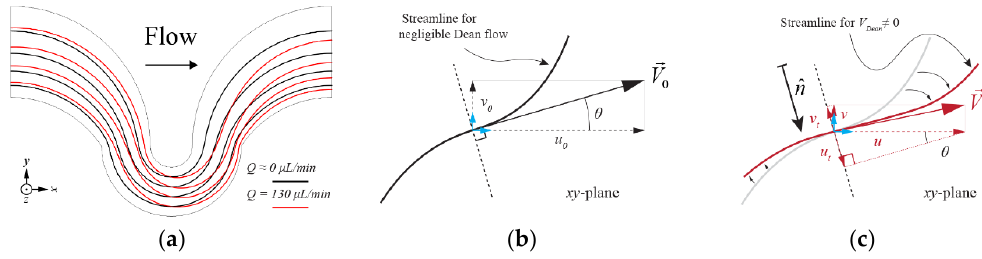
Figure 3. ( a ) Obtained streamlines for a flow with negligible Dean flow (black lines) and for Q = 130 μL/min (red lines) for h = 73 μm measured at z = 36.5 μm. Dean flows at this height displace the streamlines outwards in the central region of the curves; ( b ) decomposition, at any given point, of a flow velocity vector ( 𝑣⃗ ) to a direction perpendicular to its corresponding negligible Dean flow streamline at that point. The perpendicular direction ( 𝑛̂ ) is found using the variables u 0 and v 0 from the solution at low flow rates; ( c ) once the flow rate is increased, Dean flow appears and the velocity vector, now with v and u components, can be projected along vector 𝑛̂ .